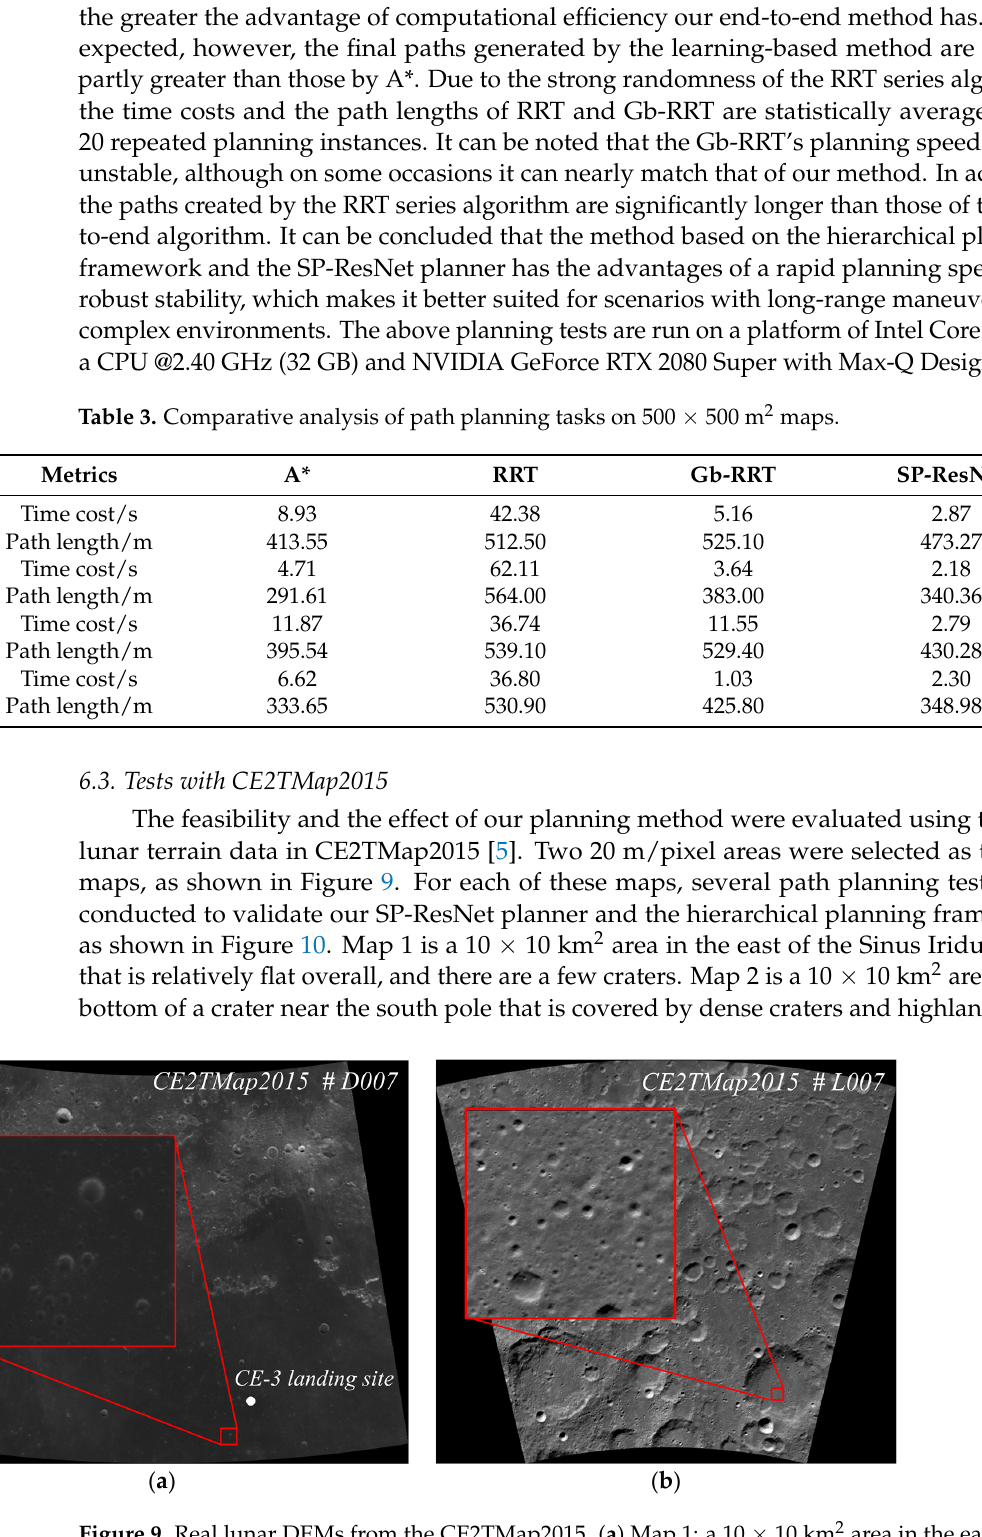
Table 3. Comparative analysis of path planning tasks on 500 × 500 m 2 maps.